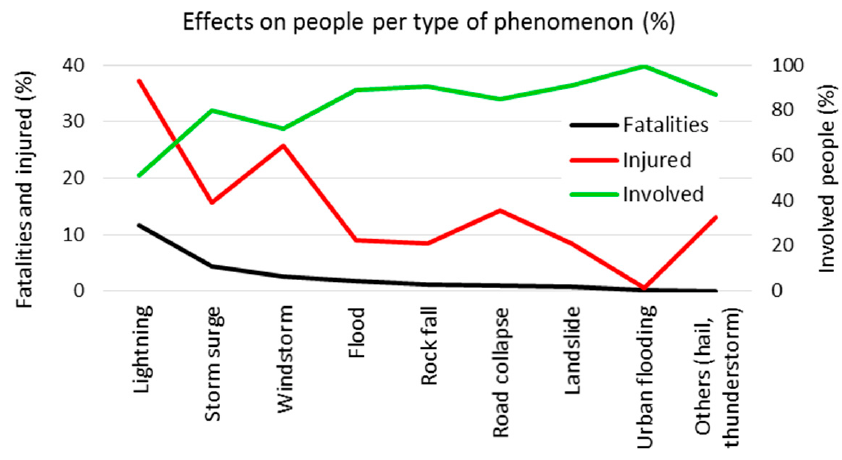
Figure 4. Percentage of fatalities, injured and involved people per type of phenomenon.